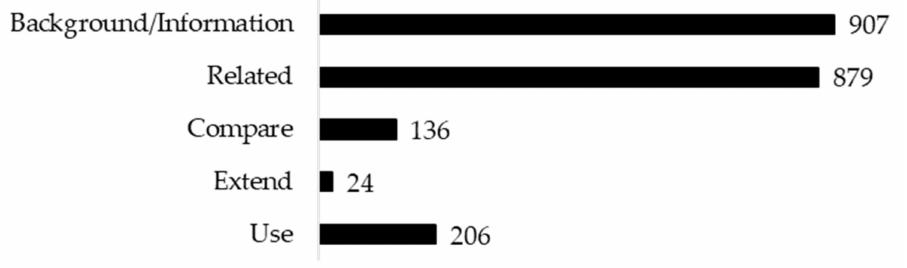
Figure 1. The number of citations in each